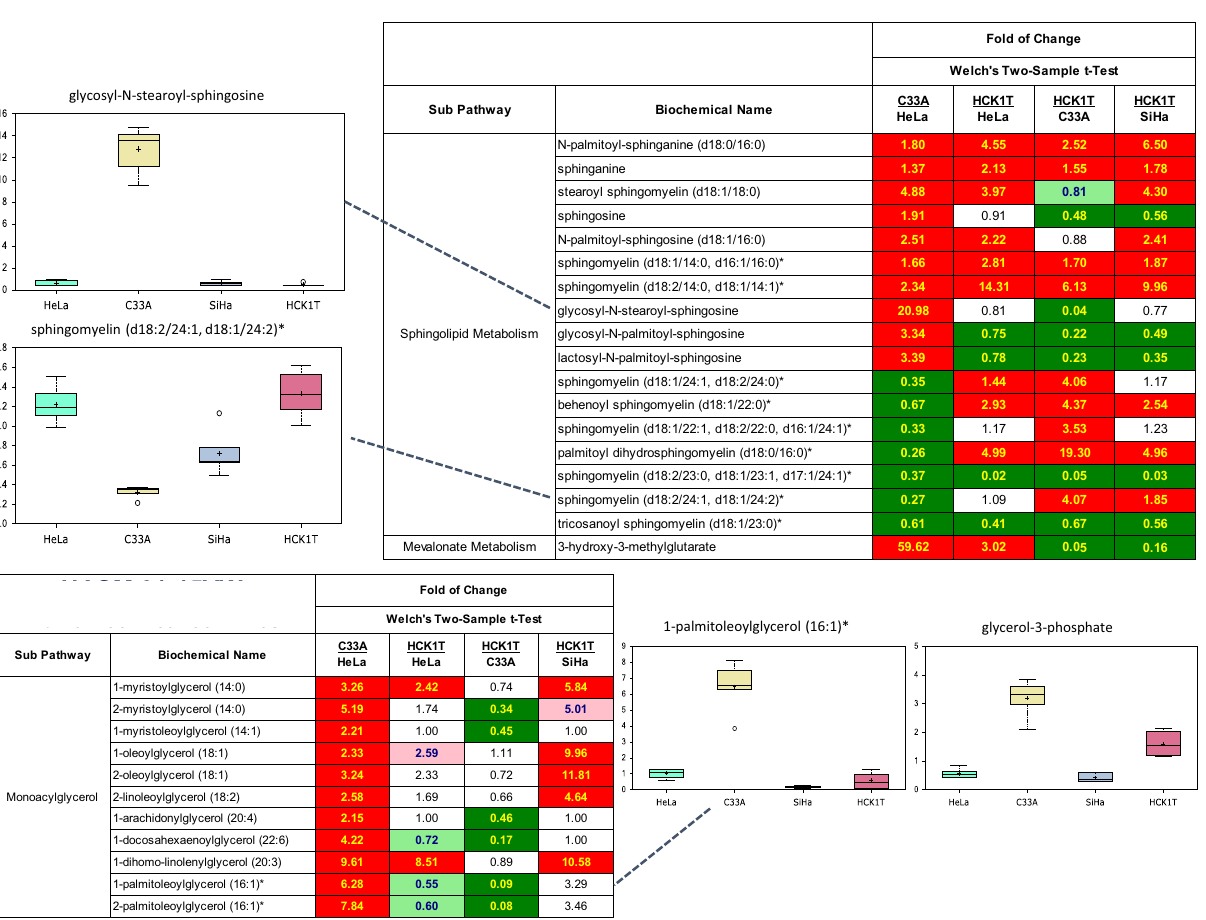
Figure 6. Metabolomic analysis of the lipid metabolism of the four cervical cell lines. Biochemicals displaying salient changes among the four cell types are shown as box plots. Each box plot provides a measure of scaled intensity, normalised by protein content. Two representative heat maps (upper and lower) with the major biochemical changes are shown. For the color key of the heat map, see the legend of Fig.